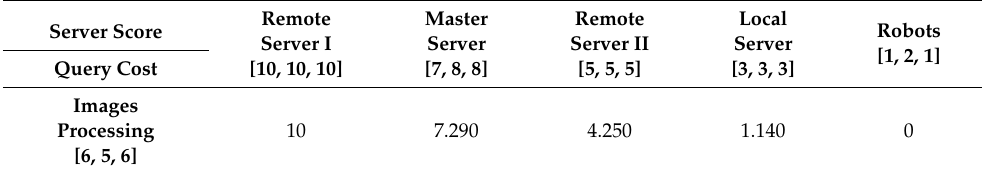
Table 8. saaq perf _ norm values for our Motivating Scenario.